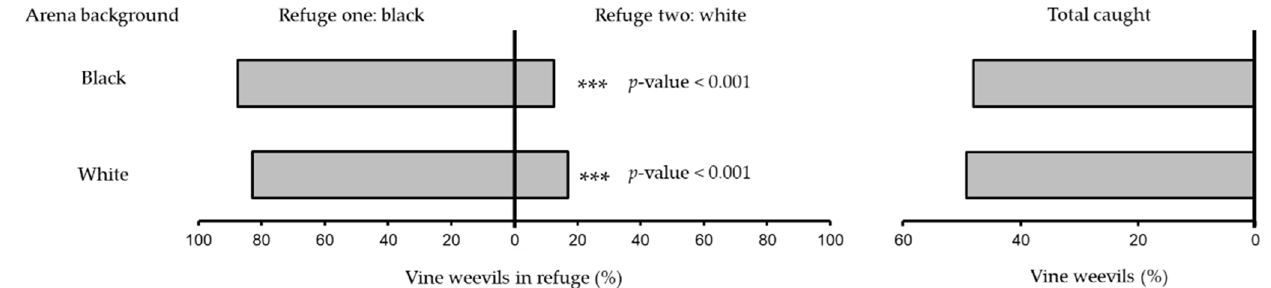
Figure 3. Percentage of vine weevil adults recorded in refuges painted black or white when released as a group of five individuals ( number of replicate days = 5) into a cage with a black background or white background. Asterisks indicates significant differences between refuge choices.